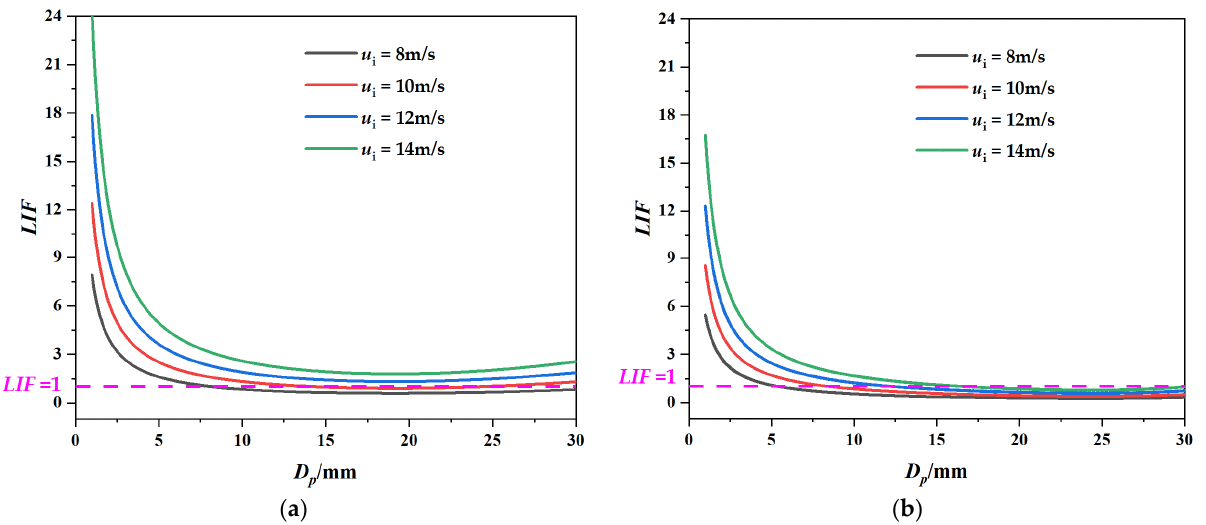
Figure 6. Pressure distribution with different u i over logarithmic spiral wall surfaces at ( a ) x / R = 1 and ( b ) x / R = 2/3.